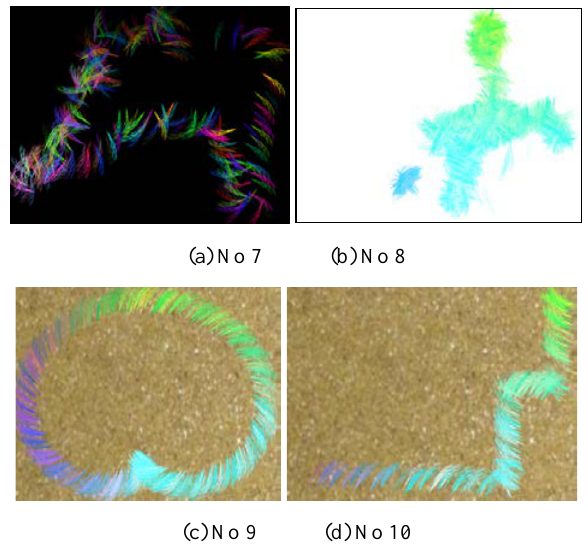
Figure 10. Rendering results with various colour modes